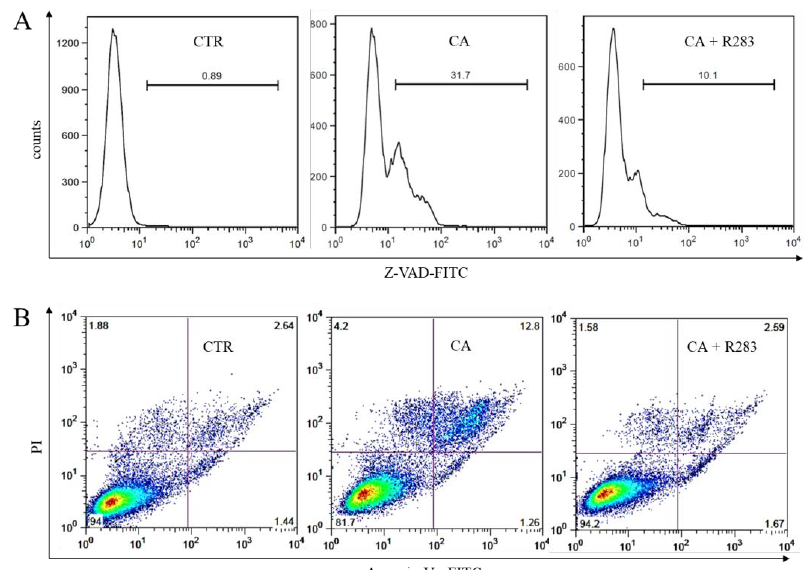
Figure 5. TG2-dependent CA-induced apoptosis in K562 cells. ( A ) The CA activates the caspase cascade 24 h after the start of treatment through a TG2-dependent mechanism. ( B ) The modulation of TG2 activity in the presence of R283 reduces the number of cells in apoptosis measured 72 h from the start of treatment. Representative acquisitions are presented.